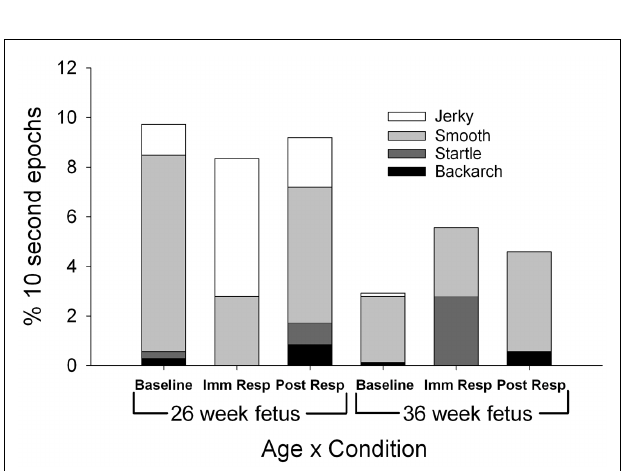
FIGURE 5 | Each column represents the average percentage of 10-s epochs for total mouthing movement (non-rhythmic and rhythmic) and yawn observed at 26 (columns 1–3) and 36weeks gestation (columns 4–6). For illustration, total mouthing movements (columns 1–3 compared to columns 4–6) were observed more frequently at the 36week assessment ( F (1,11) = 9.77, p = 0.01). and no age × period interaction [ F (2,22) = 0.020, p = 0.94]. In the fetuses at the 36-week assessment, the ratio of regular to irregu- lar breathing was 56:44 (regular to irregular) at baseline with a shift to 20:80 (regular to irregular) during the immediate response period [ χ 2 (1) = 27.5, p < 0.001]. At the 26-week assessment, the ratio of regular to irregular had a smaller shift from the base- line level (49:51 regular to irregular) to the immediate response level [33:67 regular to irregular; χ 2 (1) = 5.3, p = 0.02]. In addi- tion, vigorous fetal breathing movements were only observed at the 36-week assessment during the post-response